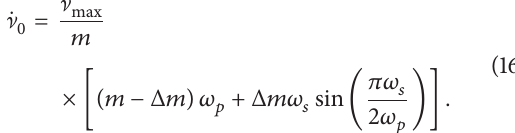
Figure 5: Percentage of energy dissipated at the first reconnection as a function of the stiffness reduction ratio 𝜎 for different values of the secondary to primary systems frequency ratio Ω (— Ω = 3 ; - - - Ω = 7 ; ⋅ ⋅ ⋅ Ω = 11 ; — Ω = 5 ; − − Ω = 9 ; - - - Ω = 13